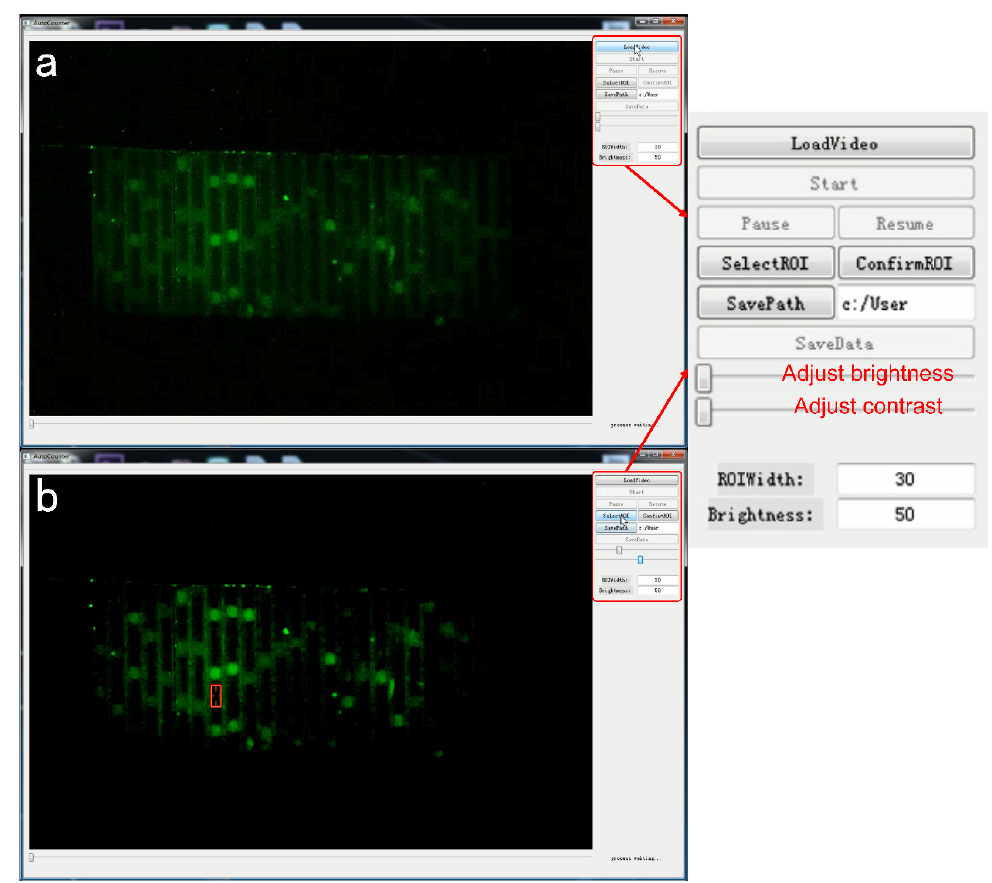
Figure 4. ( a ) Video with unadjusted brightness and contrast. ( b ) Video with adjusted brightness and contrast.